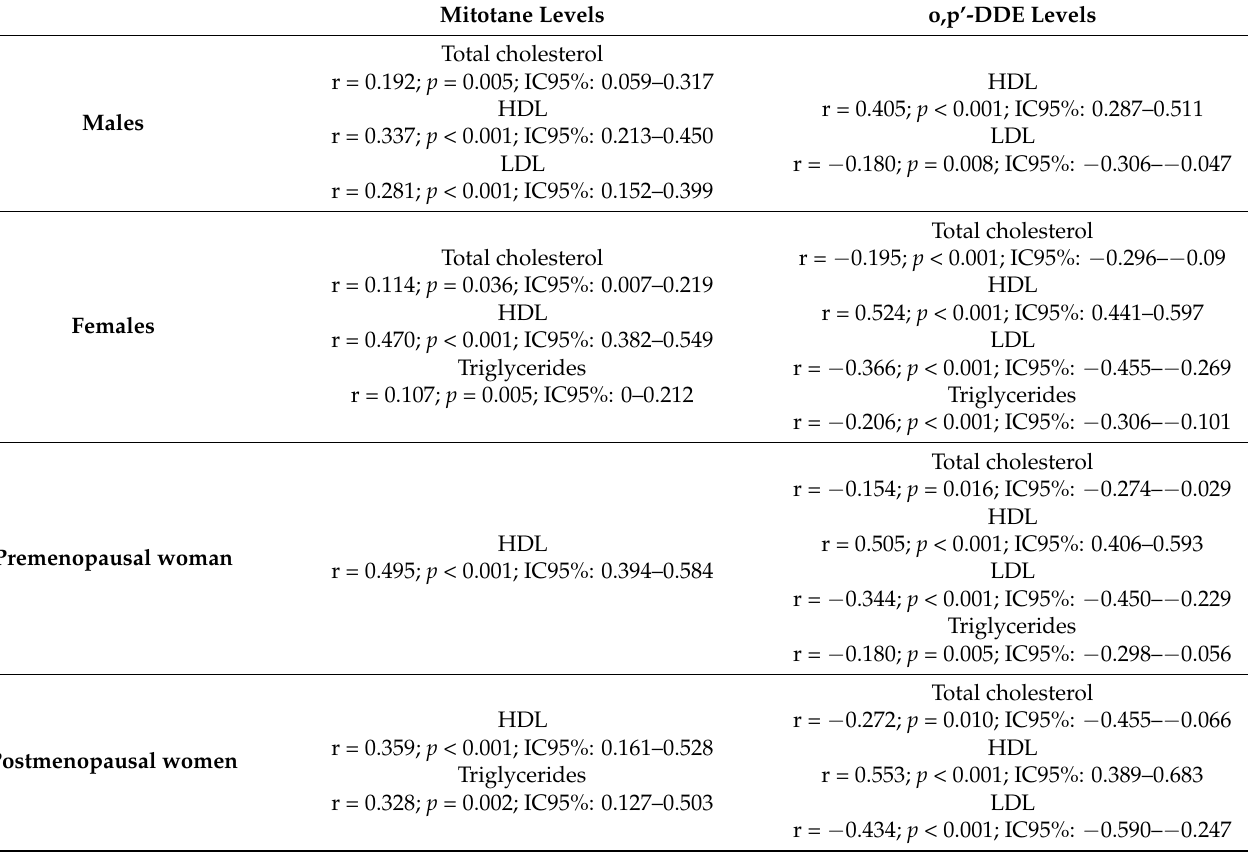
Table 3. Statistically significant results obtained with Pearson correlation